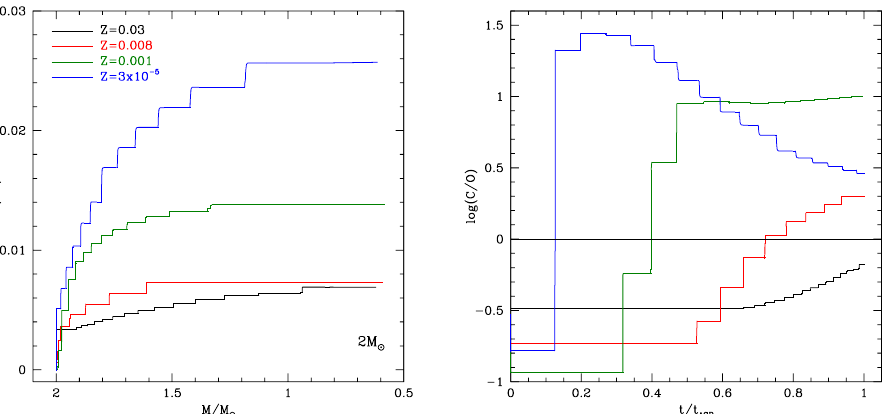
Figure 5. Variation of the surface mass fraction of 12 C ( left panel) and of the C/O ratio ( right , logarithmic scale) of model stars of initial mass 2 M (cid:12) and different metallicities, extending from the ultra-metal-poor domain to super-solar chemistries. The former quantity is shown as a function of the current mass of the star, whereas the carbon-to-oxygen ratio is reported as a function of the AGB lifetime, normalised to the overall duration of the AGB phase. The thin horizontal line in the right panel indicates the C = O condition at the surface, thus delimiting M-stars and carbon